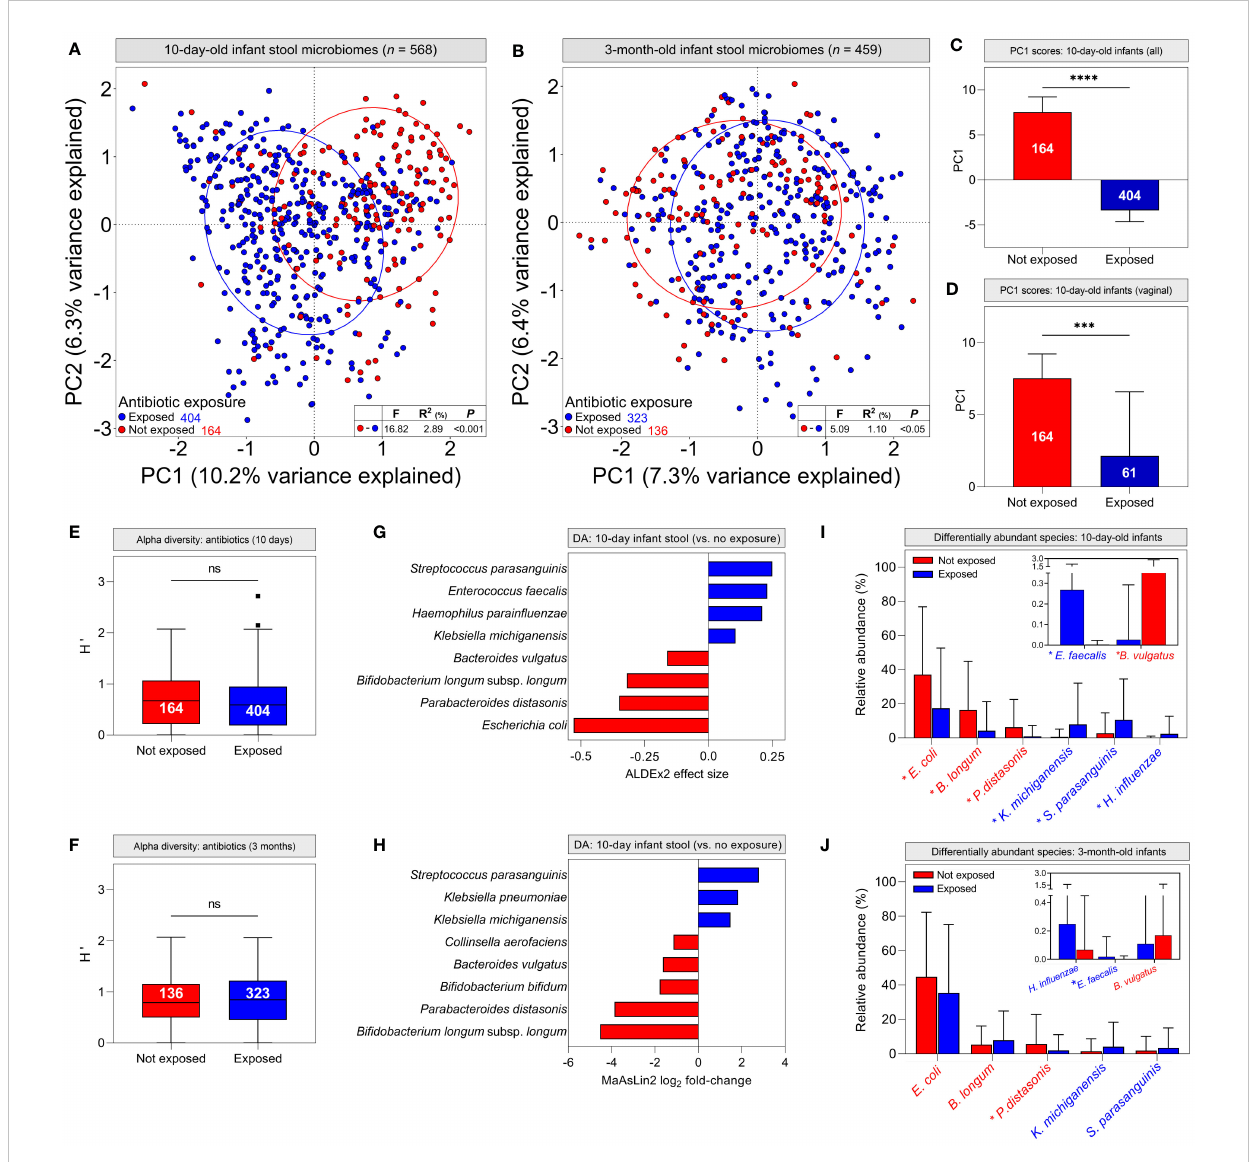
FIGURE 4 Intrapartum antibiotic exposure confounds infant stool microbiome differences commonly attributed to delivery mode: (A, B) Principal component analysis of cpn 60 stool microbiome pro fi les grouped by antibiotic exposure for 10-day ( A , pairwise PERMANOVA, P < 0.001) and 3-month ( B , P < 0.05) -old infants. (C, D) Median scores across the fi rst principal component for all 10-day-old infant stool microbiomes (C) and those delivered vaginally (D) , grouped by antibiotic exposure (bars indicate 95% CI). (E, F) Alpha diversity of stool microbiomes from 10-day (E) and 3-month (F) -old infants (bars indicate 1.5x IQR) ( C – F , Mann-Whitney U, *** P < 0.001, **** P < 0.0001, ns, not signi fi cant). (G, H) Differentially abundant taxa in 10- day-old infant stool microbiomes as determined by ALDEx2 (G) and MaAsLin2 (H) . Bar colour indicates antibiotic exposure. (I, J) Mean relative abundances ( ± s.d.) of differentially abundant taxa in 10-day (I) and 3-month (J) -old infant stool microbiomes. Asterisks indicate signi fi cantly different mean abundance (FDR-corrected Mann-Whitney U